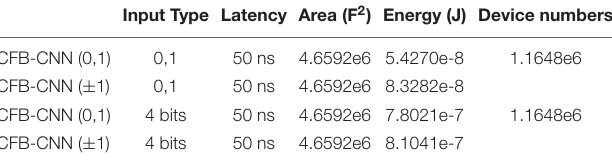
TABLE 2 | Implementation overheads.